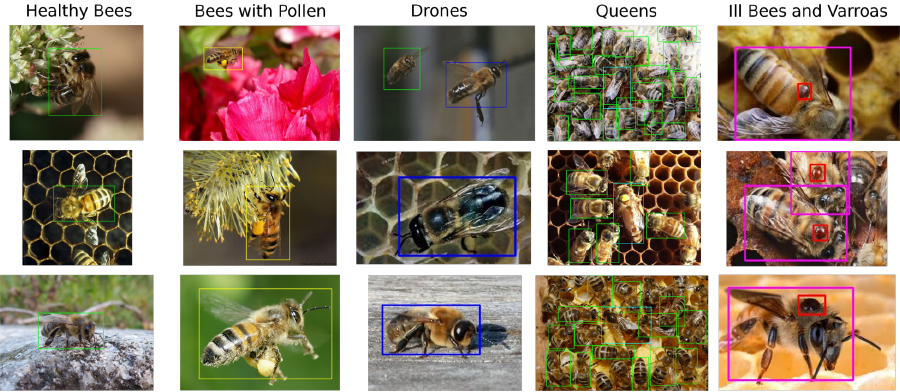
Figure 2. Brief overview of dataset created for the purpose of this work. Healthy bees (green), bees with pollen (yellow), drones (blue), queens (cyan), infected bees (purple), V.-mite